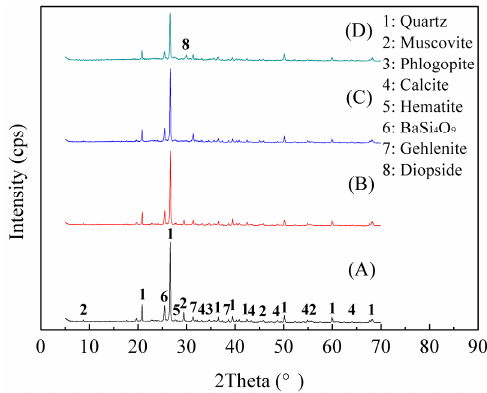
Figure 6. XRD patterns of roasting samples at different roasting temperature. ( A ) Roasting at 650 °C; ( B ) Roasting at 750 °C; ( C ) Roasting at 850 °C; ( D ) Roasting at 950 °C.